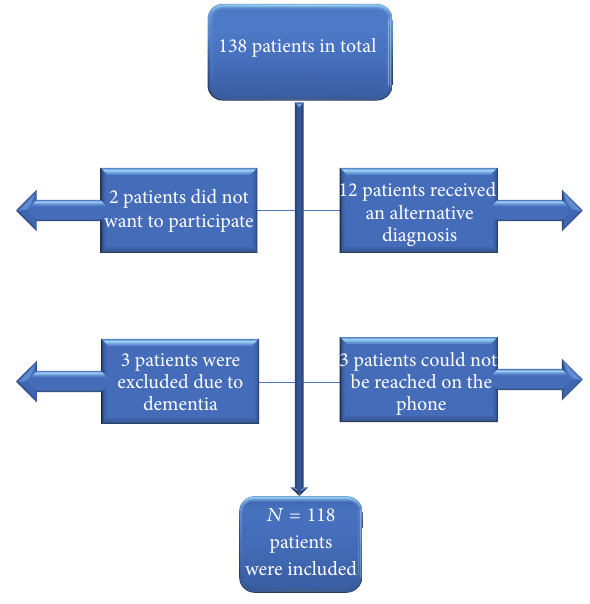
Figure 1: Patients included in the study.